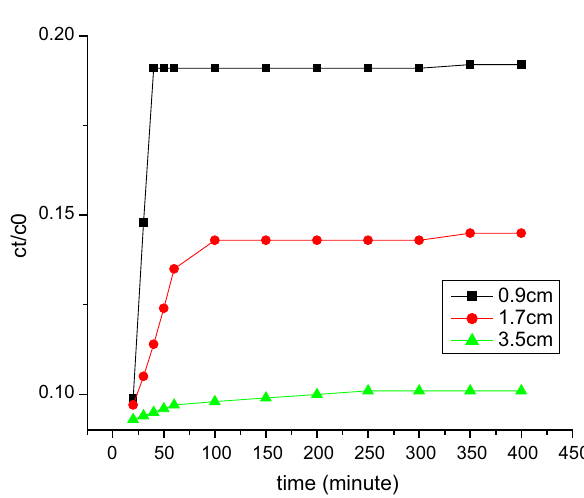
Fig. 7 Breakthrough curve of the effect of different bed depth on fluoride adsorption onto banana peel dust ( v = 3.4 ml/min, C 0 = 10.0 mg/L, pH =